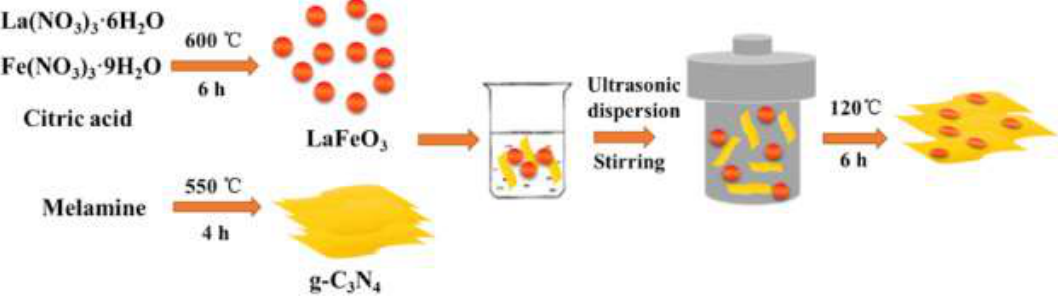
Figure 5. Schematic illustrating the synthesis of the LaFeO 3 /g-C 3 N 4 heterojunction. With permission from [121].